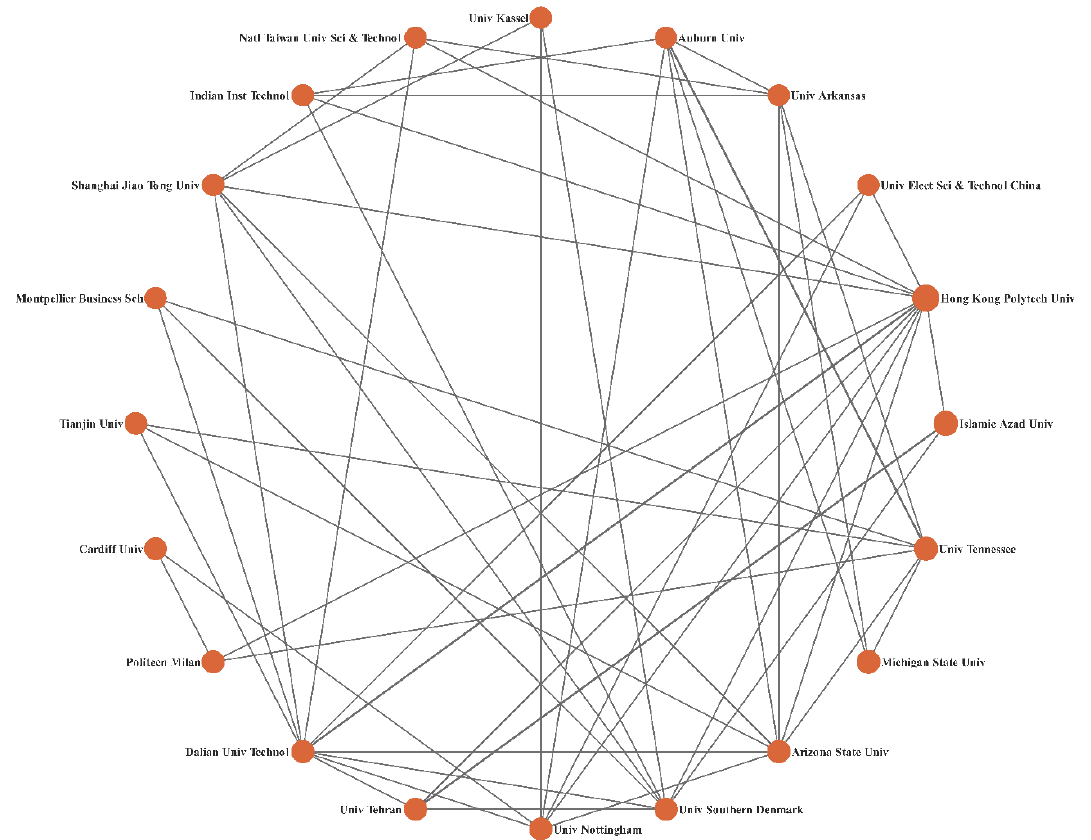
Figure 7. Collaboration matrix map among the top 20 most productive institutions of publications.